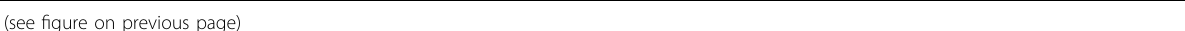
Fig. 2 The FD diet in two generations signi fi cantly increased the malformation ratio in F2 embryos. a F2 embryos with typical phenotypes from group A, B, and C were shown. F2 embryos were dissected at either E18.5 (a' – f') or E14.5 (g' – l') and gross anatomy were evaluated. a', f', and g' were from control FS group and the rest embryos were from FD diet groups. Variety of defects were observed in FD diet groups, including developmental delay (b', h', k'), missing mandible (c', red arrow), curly tail (e'), scoliosis (d', e', k', red arrows), edema (j'), abdominal fi ssure (l'), and internal hemorrhage (yellow stars in c' and d', red arrow in i'). The amount of embryos and the abnormal ratio in either E14.5 or E18.5 were presented in panels b and c , respectively. d The total abnormal ratio were presented. e F2 embryos with typical phenotypes from group A', B', and C' were shown. Only embryos at E18.5 were dissected for these three groups. Again, variety of defects were observed in FD diet groups, including developmental delay (b'', c''), curly tail (red arrows in f'', g''), internal hemorrhage (red arrows in d'' and h'') and parietal encephalocele (d''). f The amount of embryos and the abnormal ratio in these three groups were